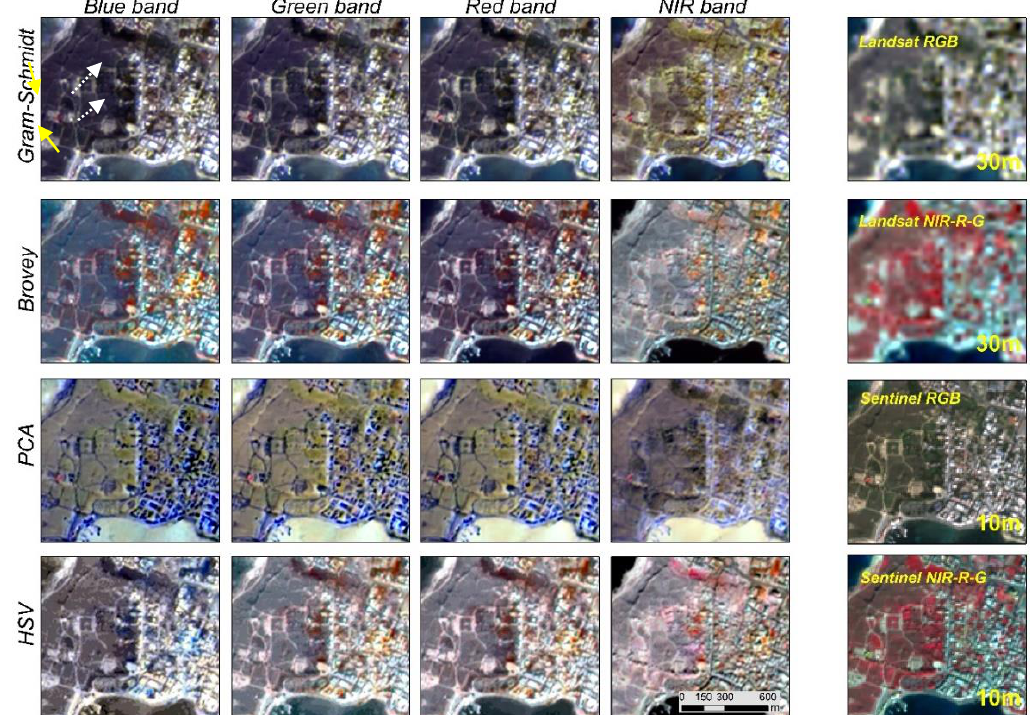
Figure 5. Fusion results of the whole archaeological site of “Nea Paphos” (area c, Figure 1) using the four different pansharpening methods (Gram–Schmidt, Brovey, PCA, and HSV, at the first to fourth row, respectively) based on the different Sentinel 2 (10 m) spectral bands used as the panchromatic image (columns). The last column indicates the original 30 m Landsat 8 and Sentinel 2 10 m pixel resolution images at the red, green, and blue (RGB), and near-infrared green and blue (NIR-R-G) pseudo composites. Excavated areas are indicated with yellow arrows and the boundary of the archaeological site with the modern city of Paphos is indicated with white arrows.